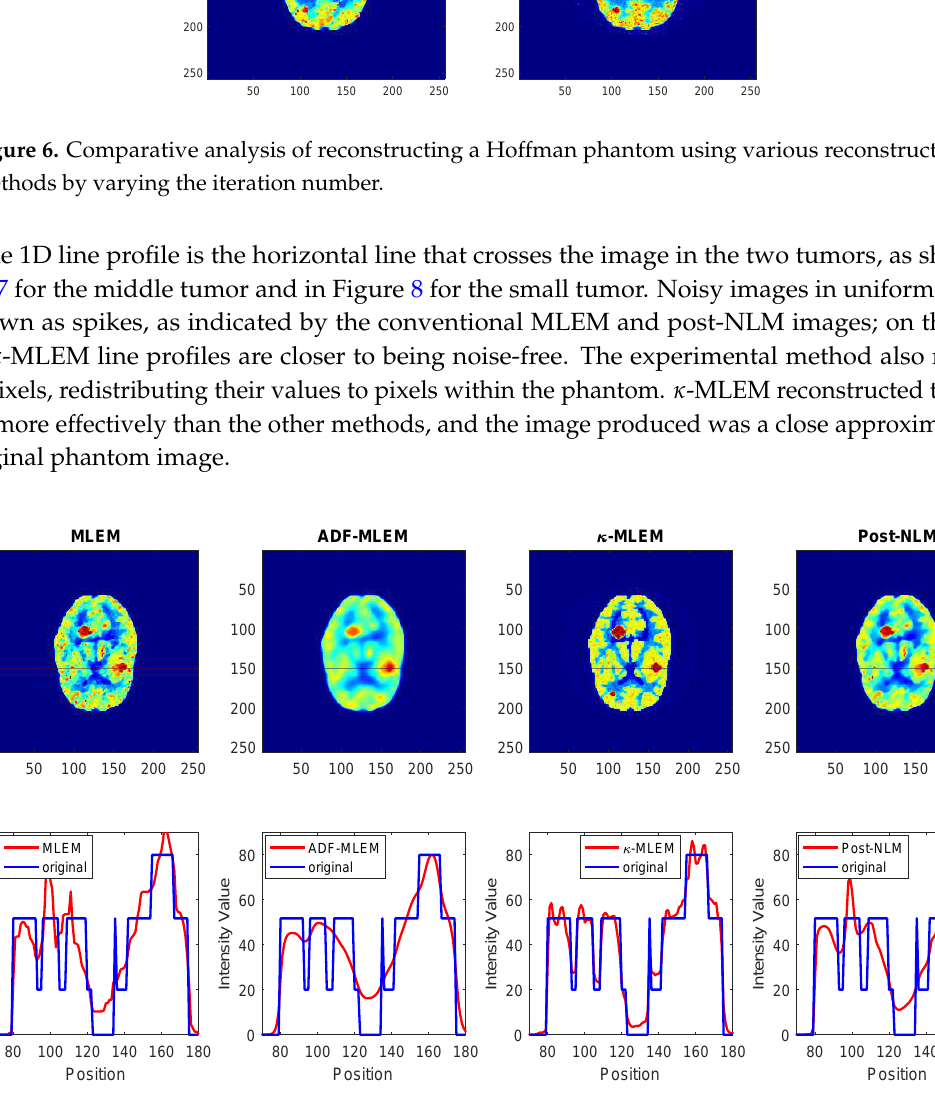
Figure 7. 1D profiles corresponding to reconstructed images for the middle